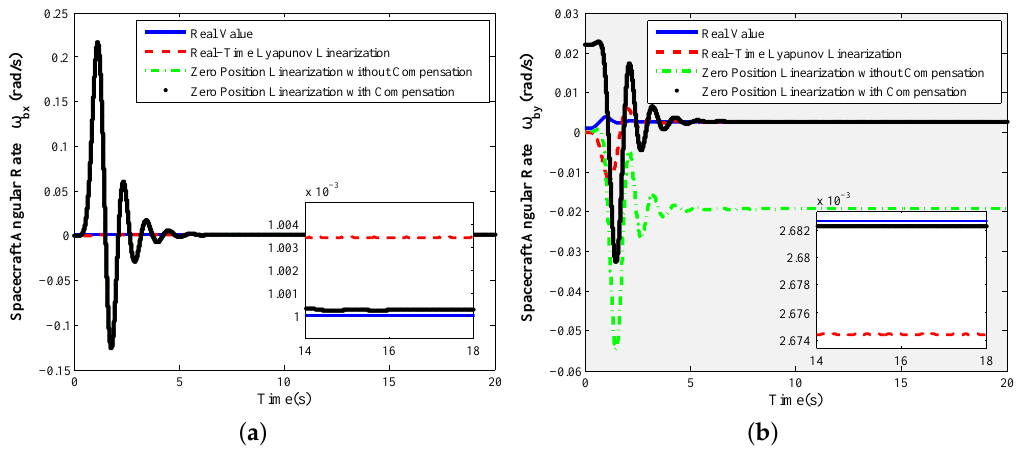
Figure 7. Static measurement φ xd = 4.8 ◦ , φ yd = 0 ◦ , constant motor spin rate ˙ θ zd = 157.04 rad/s: ( a ) X -axis angular rate sensing of spacecraft ω bx ; ( b ) Y -axis angular rate sensing of spacecraft ω by . Especially, the response curves of the X-axis tilt control commands given by 0.1 ◦ and 4.8 ◦